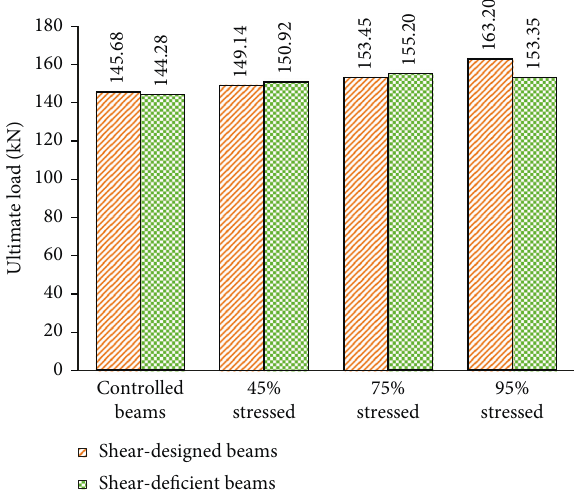
Figure 10: Comparison of ultimate loads of shear-designed and shear-deficient beams tested at a / d